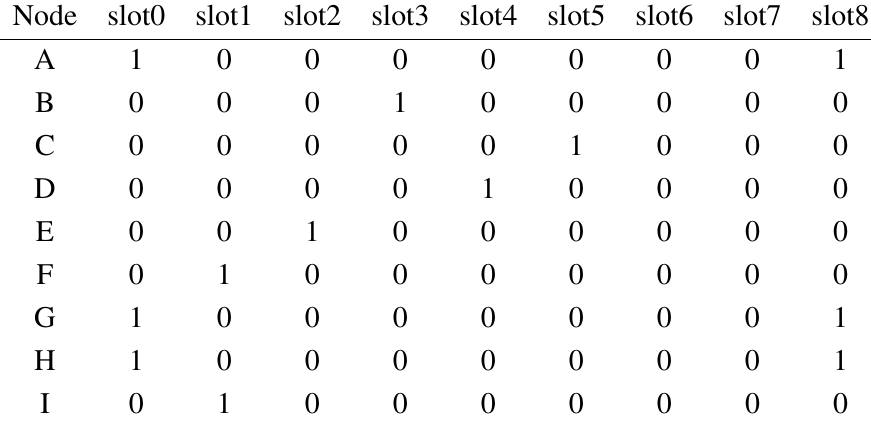
Table 3. Slot schedule with Z-MAC.